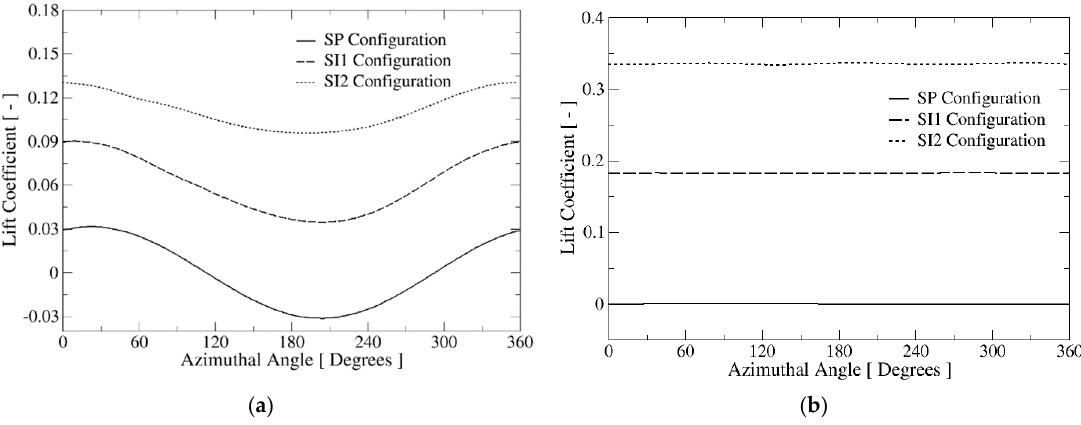
Figure 8. The lift coefficient at λ = 5.7 for the three studied configurations, SP, SI15 (15°) and SI30 (30°) inclined with respect to the flow direction: ( a ) one blade; ( b ) complete turbine.